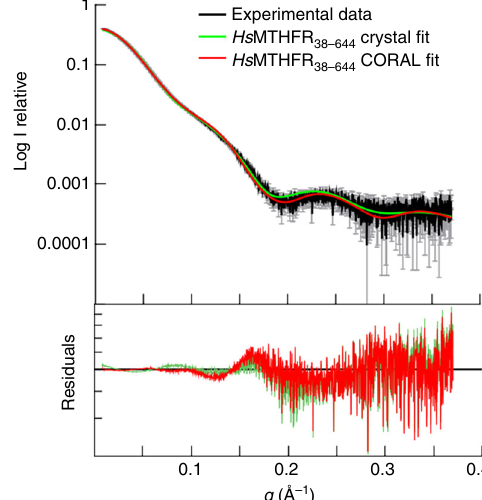
Fig. 5 SAXS analysis of Hs MTHFR 38 – 644 and Hs MTHFR 1 – 656 phosphorylated and dephosphorylated. SAXS analysis of Hs MTHFR 38 – 644 . Experimental scattering pro fi le is shown in black, theoretical scattering curve of the Hs MTHFR 38 – 644 dimer observed in the crystal is in green and that of the rigid body modelling by CORAL is in red. Chi 2 was determined by CRYSOL